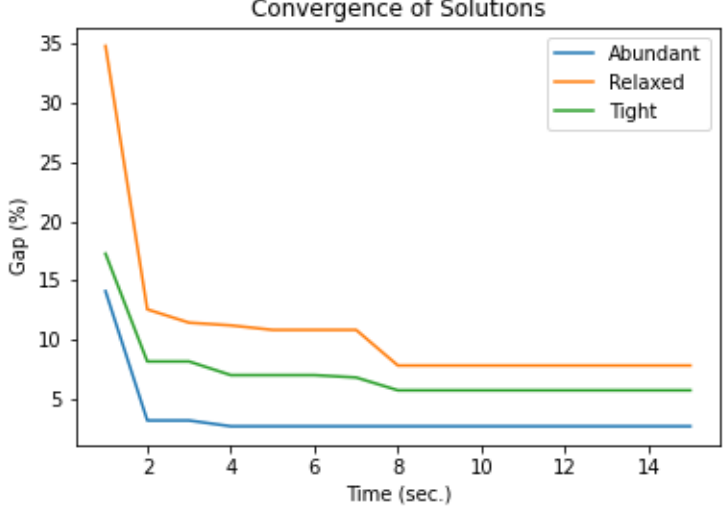
Figure 6. Comparison between MS BRLH and MAC on solving large-sized